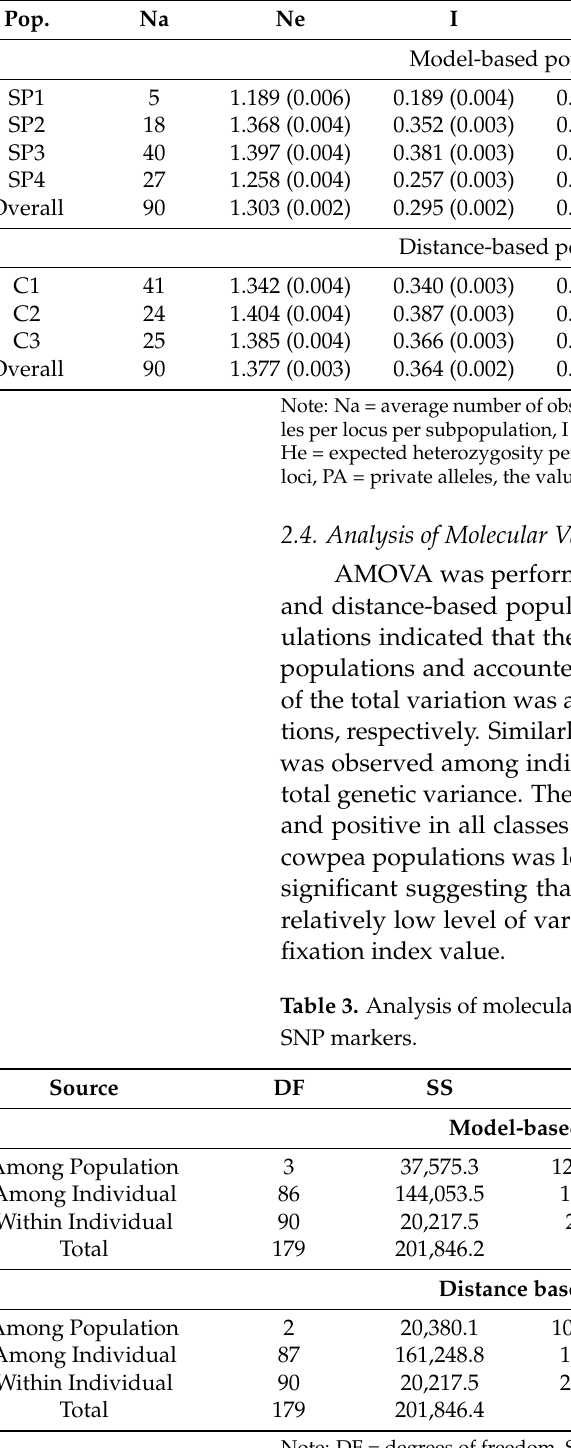
Table 2. Genetic diversity within and among the 90-cowpea accession classified by growth habit.